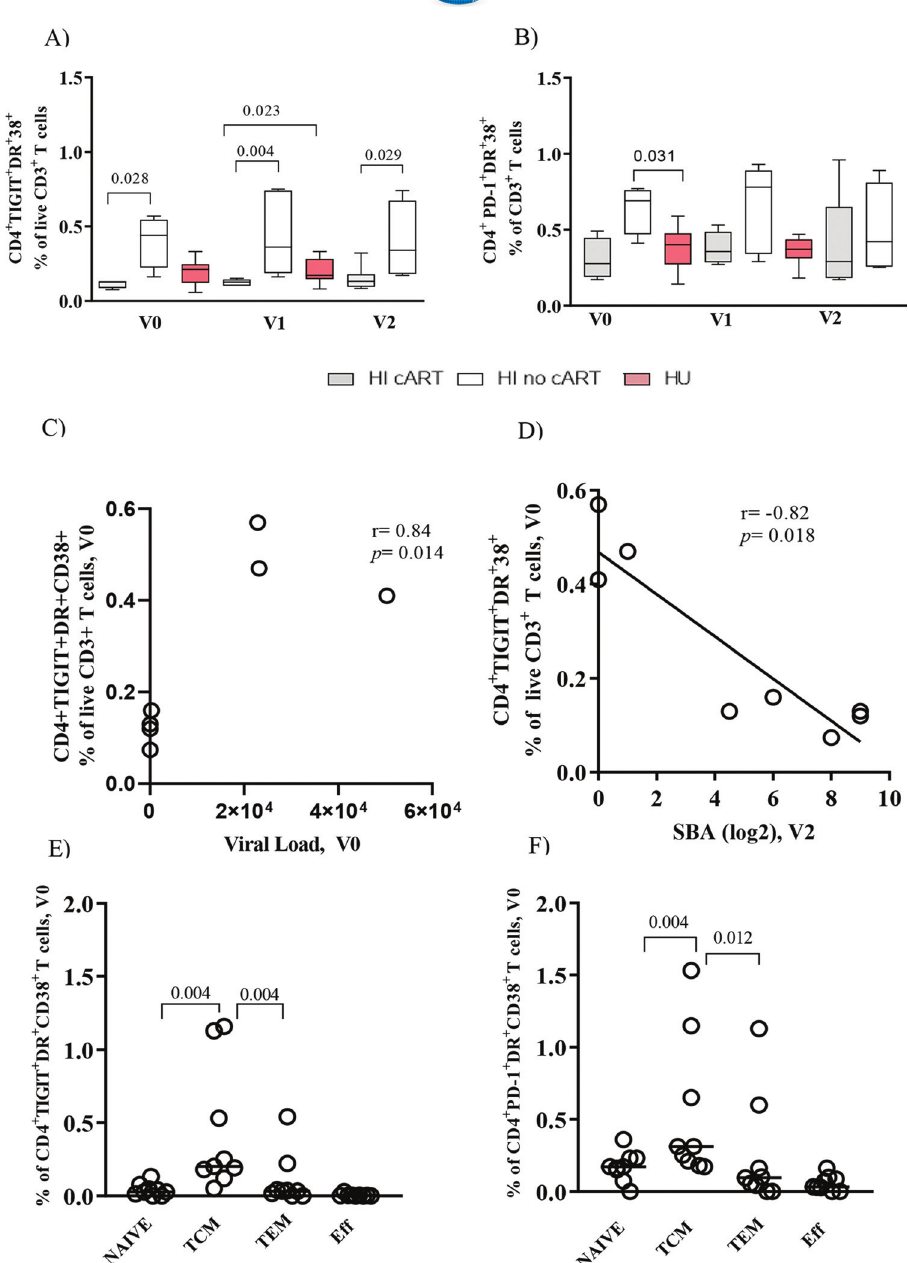
Figure 1 - Co-expression of exhaustion (TIGITor PD-1-DR-CD38) markers on bulk CD4 + Tcells and TCM in the human immunodeficiency virus (HIV)-infected (HI) or HIV-uninfected (HU) cohorts. Associations with viral load and serum bactericidal antibody (SBA). Frequency of CD4 + T cells co-expressing (A) TIGIT-DR-CD38 and (B) PD-1-DR-CD38 at all time points of the study (V0, V1, and V2). Spearman correlation analysis for assessing the correlation between the baseline TIGIT+DR+CD38+CD4+ Tcells and (C) Viral load (V0), and (D) SBA titers (V2) for the HI cohort (combined antiretroviral therapy (cART) and no-cART). Frequency of TCM cells co-expressing (E) TIGIT-DR- CD38 and (F) PD-1-DR-CD38 in the HI cohort (cART and no-cART). PBMCs were obtained before vaccination (V0), after one MCC dose (V1), and after two MCC doses (V2). The lines represent the median values. The p-values were calculated using the Mann-Whitney test. Statistical significance was set at p o